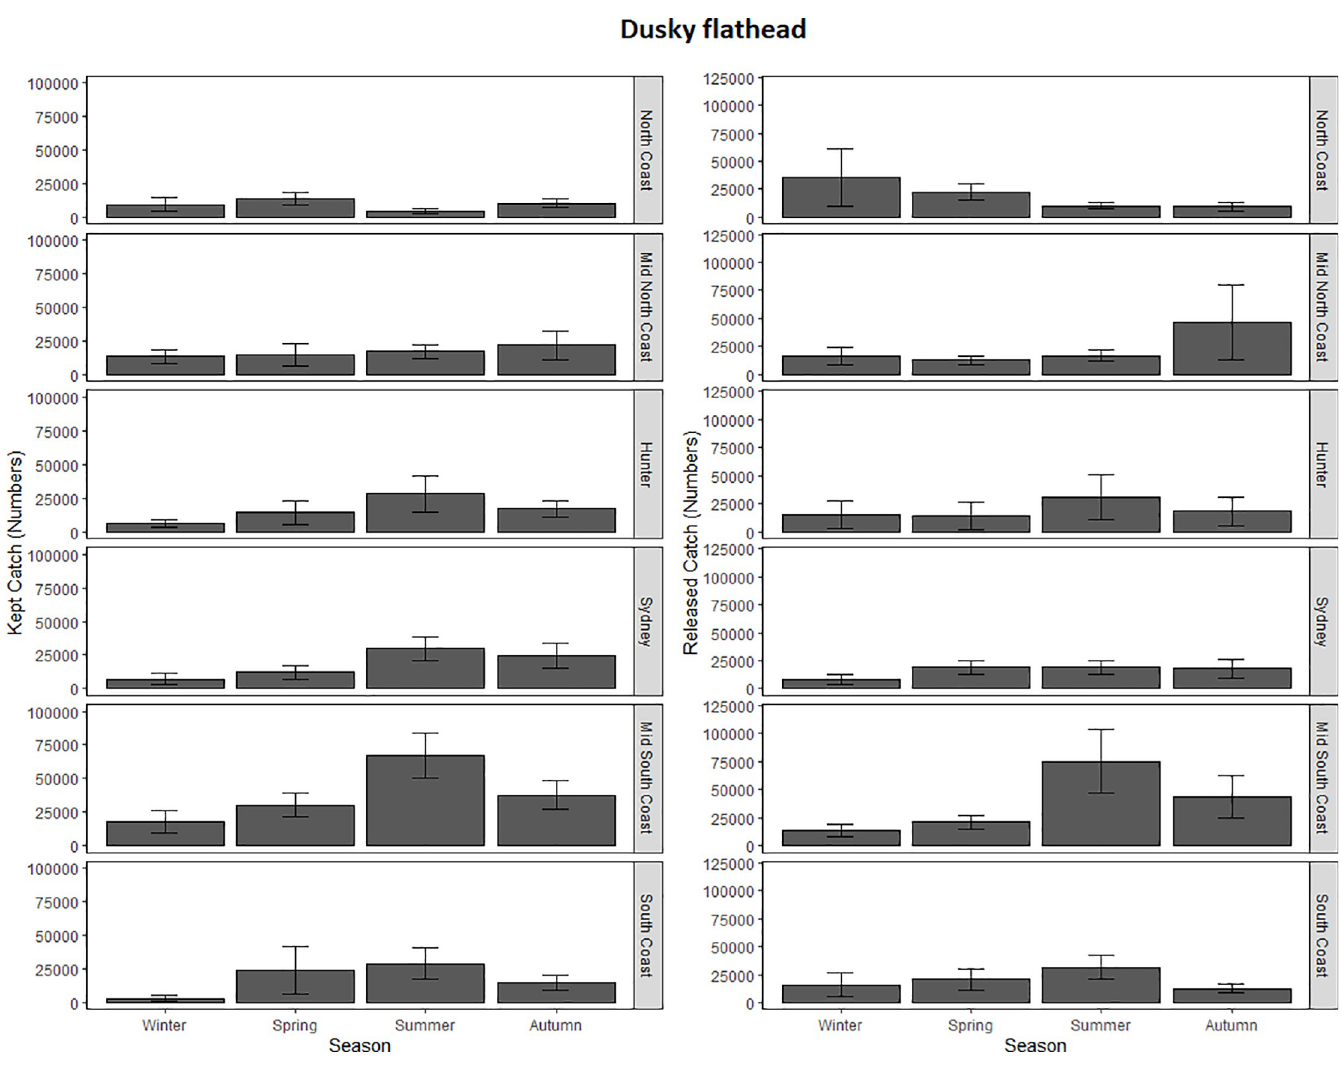
Comparison of current findings and previously documented